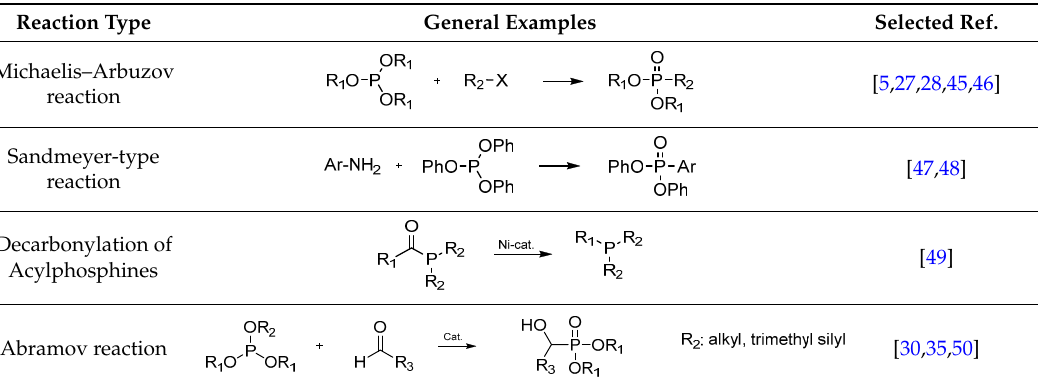
Table 3. C-H to C-P transformation. General Examples Selected Ref.